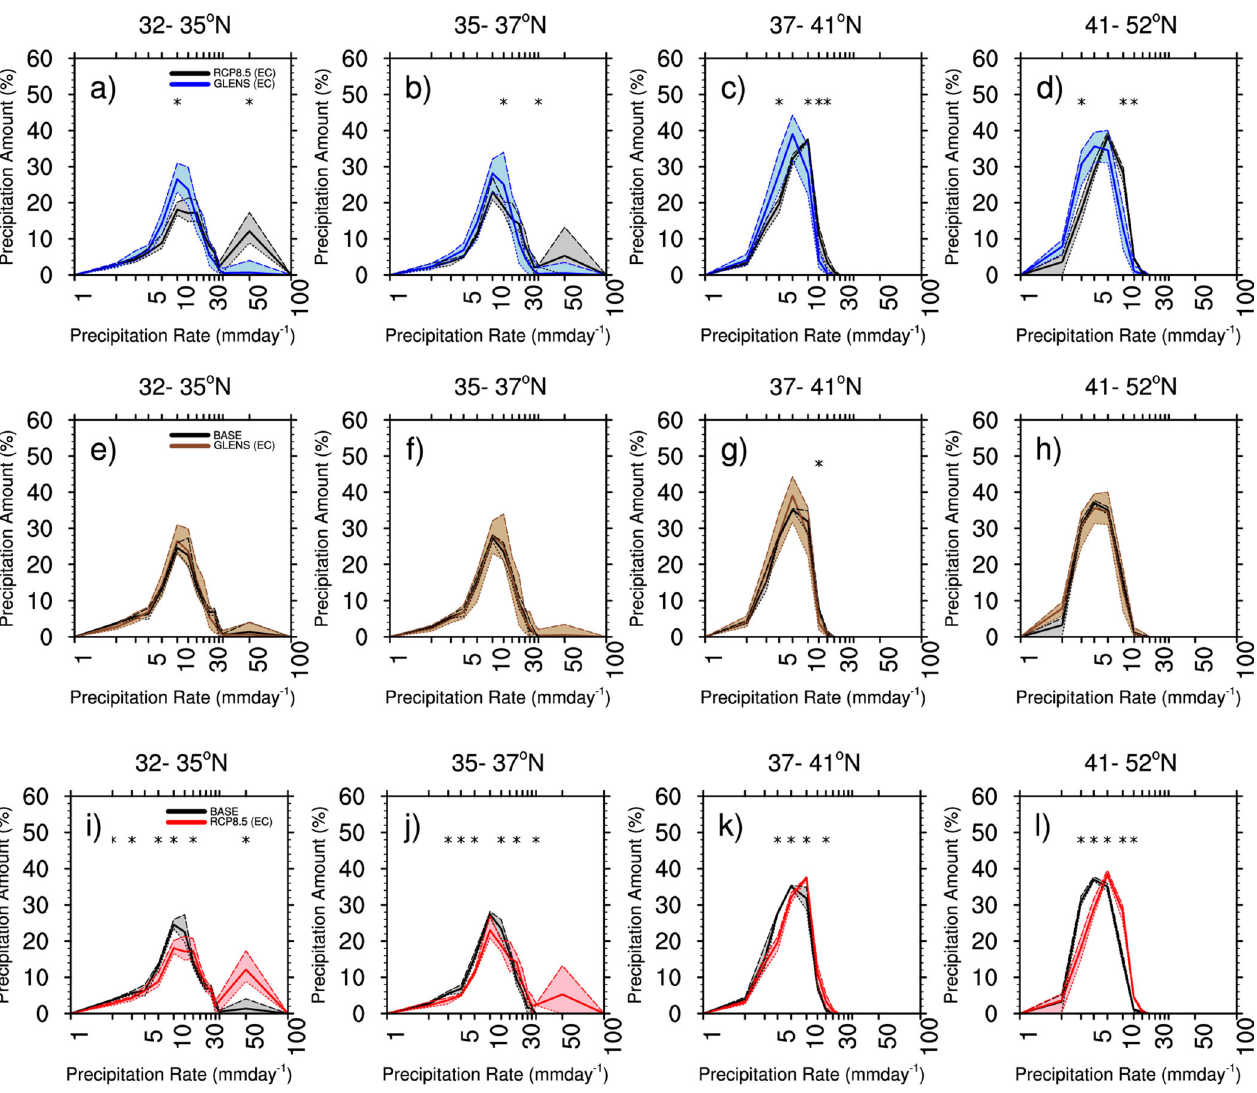
Fig. 5 Pineapple Express AR precipitation intensity rates. Pineapple Express AR precipitation intensity rates (x-axis, mmday − 1 ) and rain amount (%) for GLENS end of century (EC) (blue/light blue) compared to RCP8.5 (EC) (black/gray) ( a – d ), GLENS (EC) (brown/tan) compared to BASE (black/gray) ( e – h ), RCP8.5 (EC) (red/pink) compared to BASE (black/gray) ( i – l ). Black and gray in each grouping are used to denote the reference period consistent with Figs. 2 – 4 and are given different color-themes to highlight analysis scenarios. For example, the blue lines in a – d are the same as black lines in i – l . Lighter colors and shading represent ensemble spread, long dashes represent maximum value, small dashes represent minimum value, and starred markers above each curve show signi fi cance where there is no overlap in ensemble spread between analysis periods compared. Precipitation is averaged across 110 – 130°W for latitudes 37 – 52°N and 116 – 130°W for latitudes 32 –